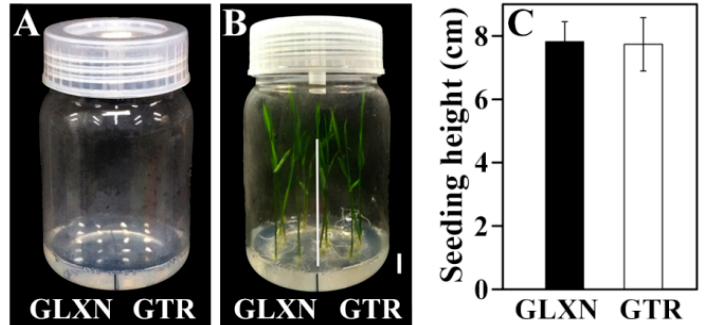
Figure 3. The in vitro culture of the mature embryo. ( A , B ): the 0 and 6 days after in vitro culture, respectively, scale bar = 1 cm; ( C ): the shoot height at 6 days after in vitro culture. The values are means ± SD ( n = 30), and the GTR data have no significant difference from the GLXN data ( p = 0.785).